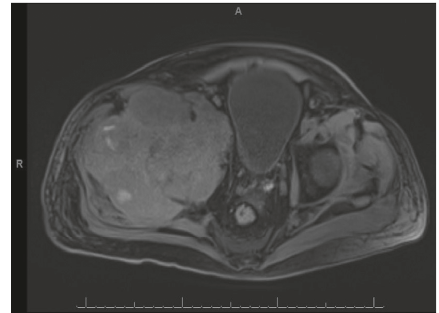
Figure 2: Large right iliac mass and associated destruction of surrounding osseous structures with involvement of right hip